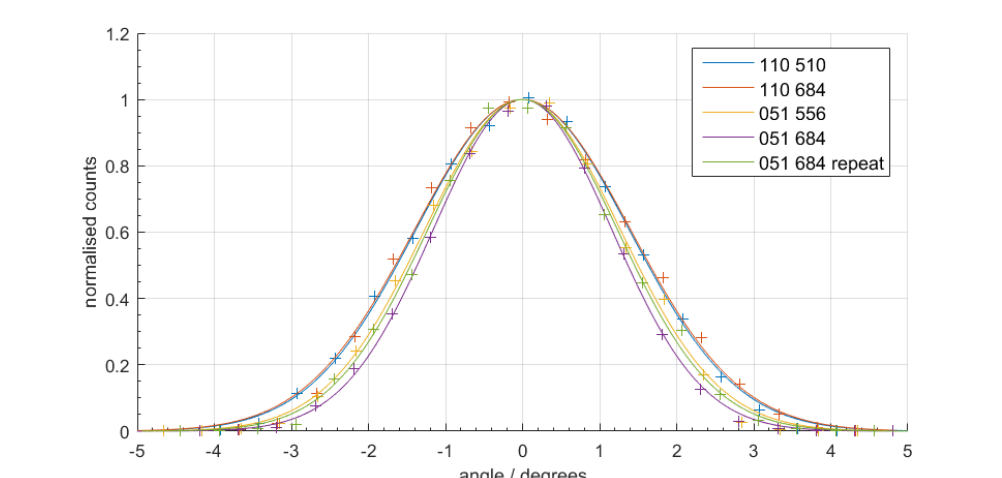
Figure 3. Measurement results to confirm the field of view (FOV) of the transfer radiometers being used in the FRM4SOC radiance round robin. The numbers in plot legend refer to the radiometer serial number and the spectral band (in nm)